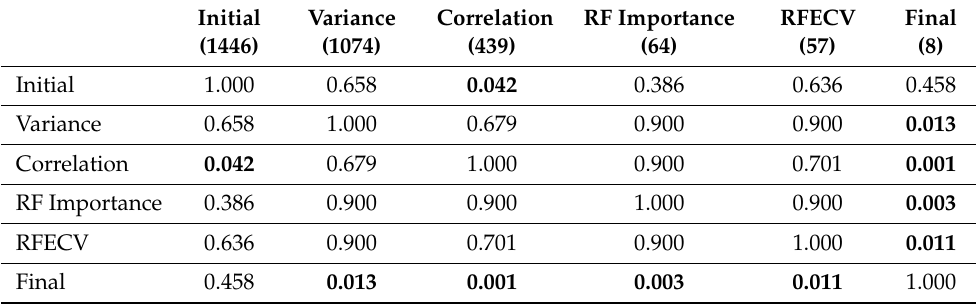
Table 2. The p -values for each pairwise comparison using Nemeyi post hoc test. The number of features for each set is given in parentheses. The statistically significant differences ( p < 0.05) are highlighted in